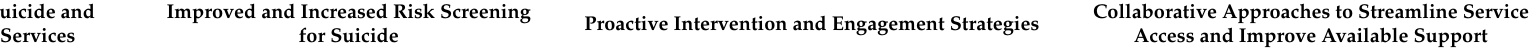
Table 3. Summary of International Student Suicide Prevention